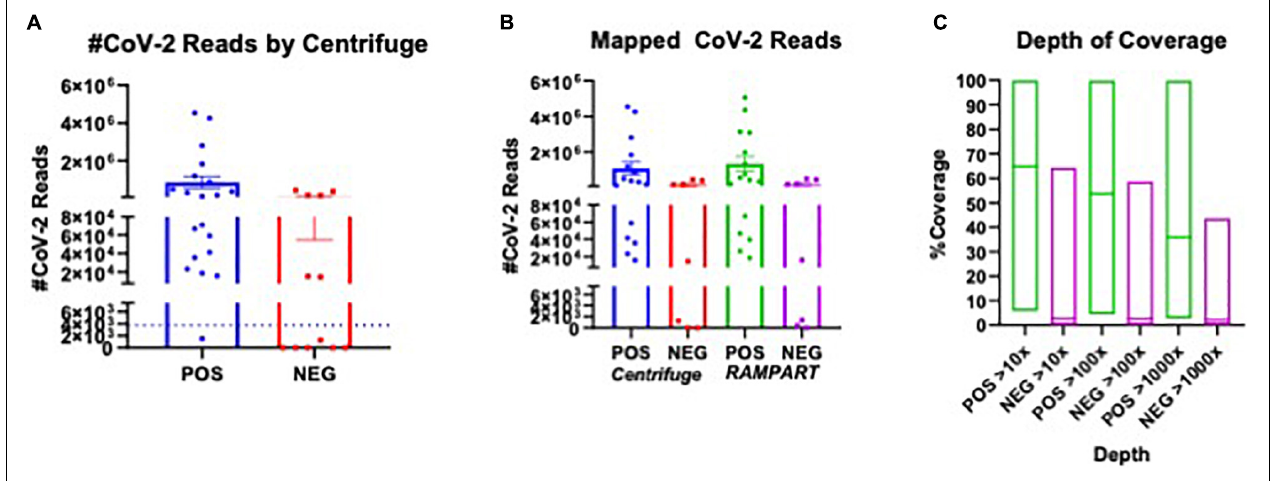
FIGURE 3 | Plot of CoV-2 Reads and Coverage as analyzed using Centrifuge and RAMPART. The number of SARS-CoV2 specific reads for sequenced COVID-19 RT-PCR positive (POS) and RT-PCR negative (NEG) and genome coverage are presented. (A) Plot of CoV-2 reads identified using Centrifuge in all POS versus NEG samples sequenced using the ARTIC with Rapid sequencing protocol. (B) Comparison of POS versus NEG samples that were analyzed using both Centrifuge and RAMPART pipelines. The number of CoV-2 specific reads are shown. (C) The depth of coverage at > 10X, > 100X, and > 1,000X as determined by RAMPART analyses are shown for POS versus NEG